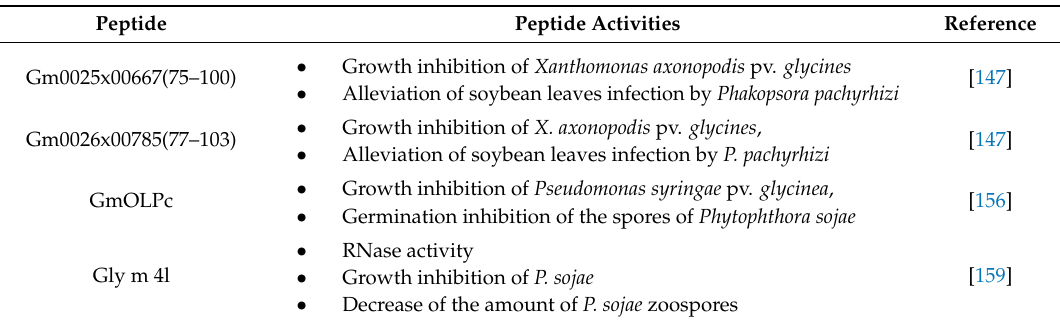
Table 3. Characterized antimicrobial peptides from soybean.